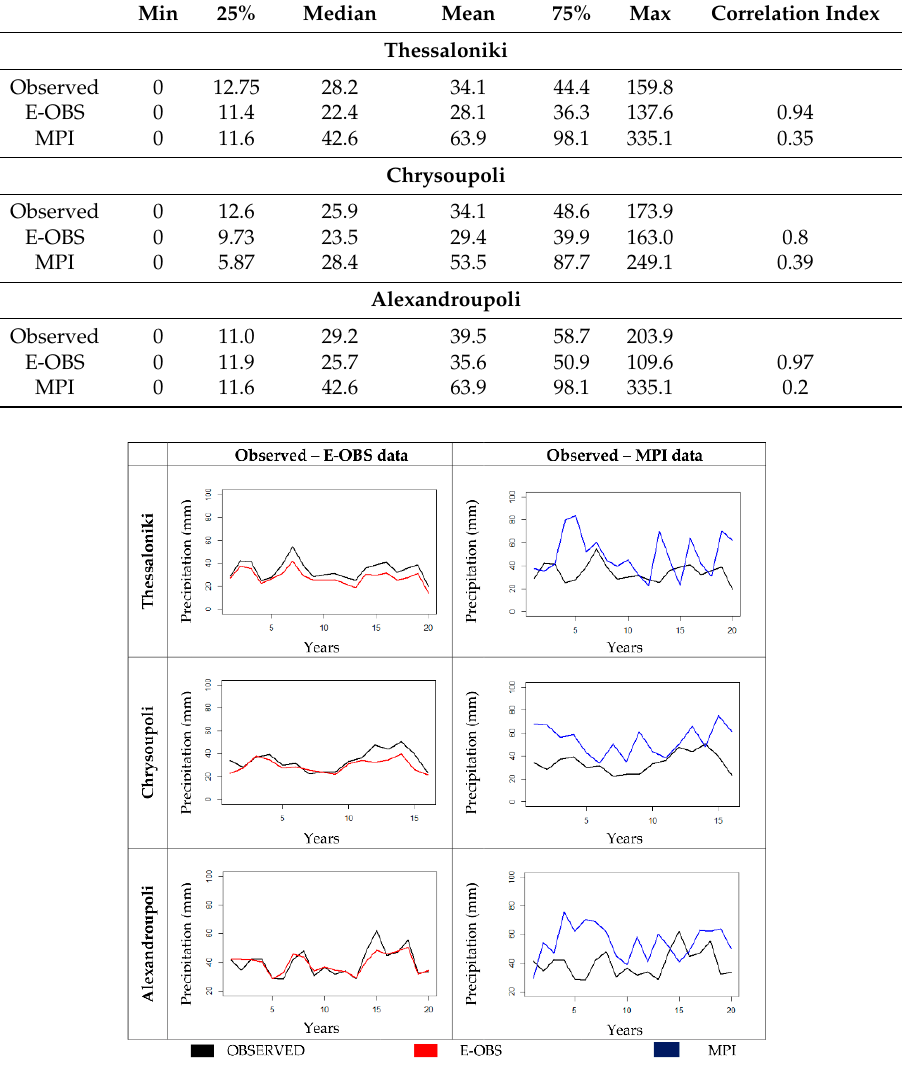
Figure 3. Comparison of the observed, E-OBS and MPI precipitation for the three Greek stations.